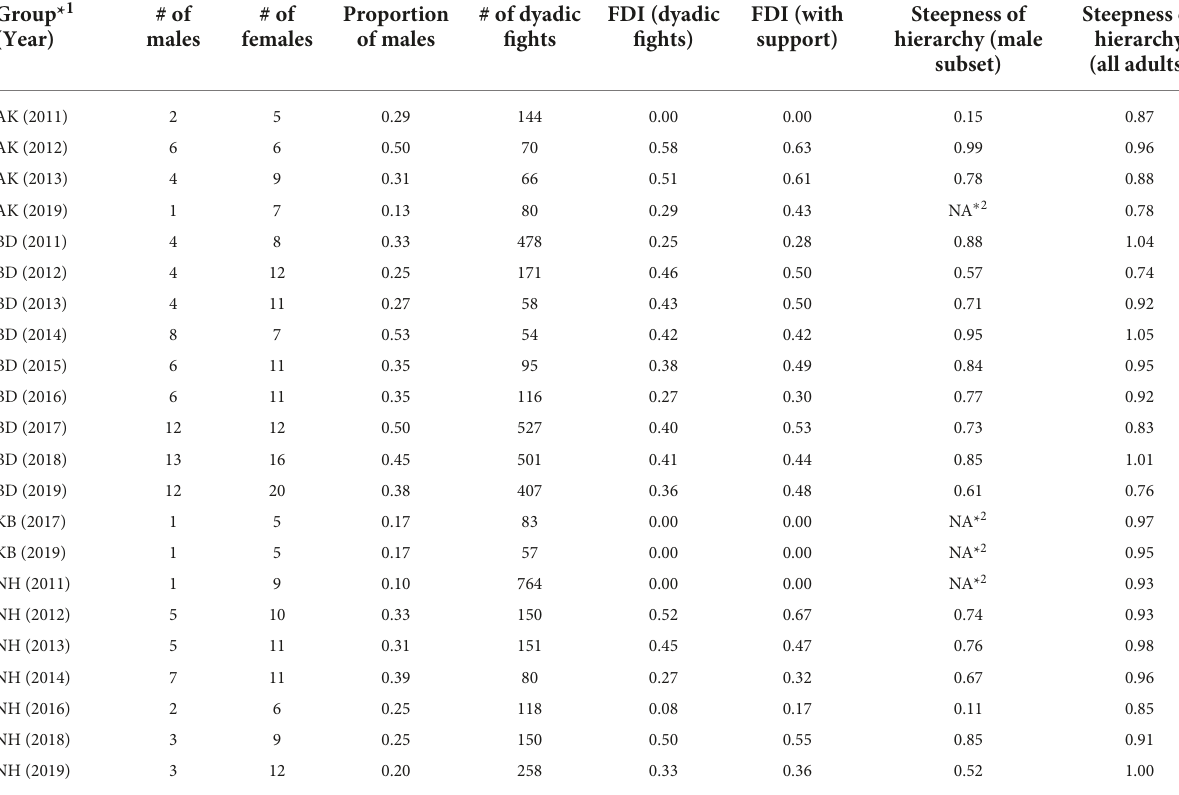
TABLE 1 Information on groups per year (in parentheses) regarding the number (#) of adults of each sex, the proportion of males, the number of dyadic fights, the degree of female dominance (i.e., Female Dominance Index) from dyadic interactions and when interactions with support were added to the calculation of the dominance hierarchy, and the steepness of the hierarchy of all adults and of males